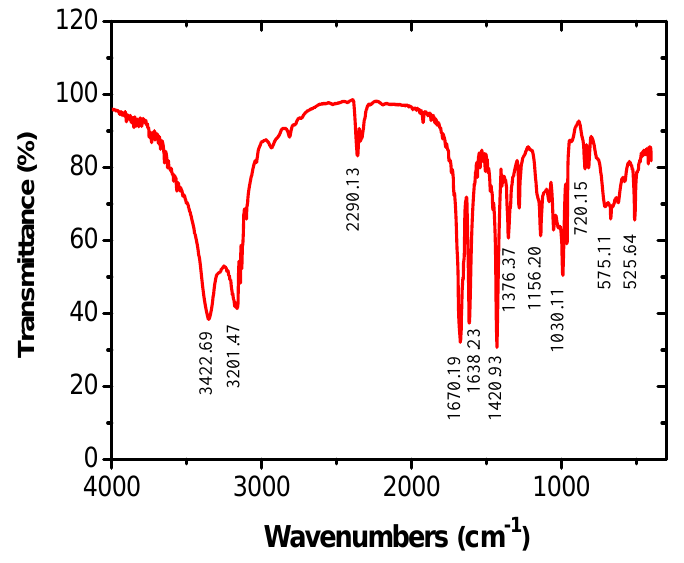
Figure 4. FTIR spectra of the GCF.